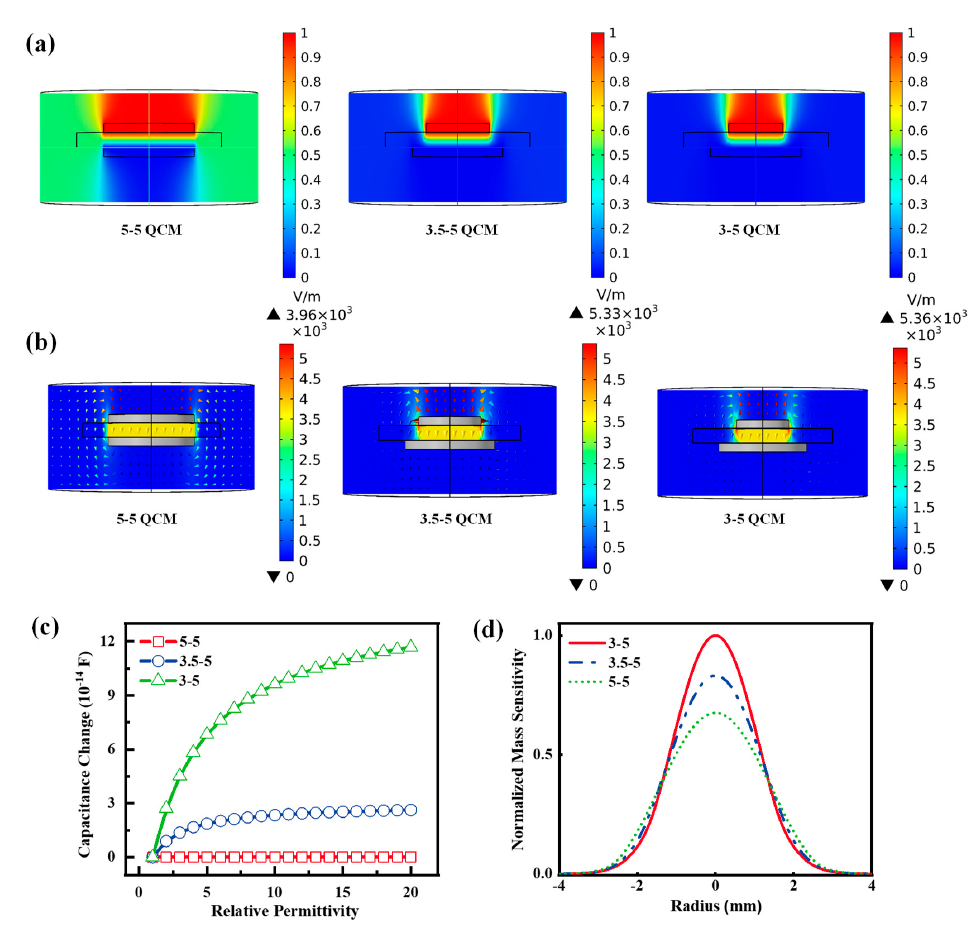
Figure 7. ( a , b ) The distribution of the potential and electric field of 5-5 QCM, 3.5-5 QCM, and 3- 5 QCM. ( c ) The normalized mass sensitivity of the QCM with symmetric and asymmetric electrodes. ( d ) Simulation results of capacitance change VS relative permittivity for the 5-5, 3.5-5, and 5-5. For simplicity, 4 mm diameter, 500 nm-thick cylinders were placed in the center of QCMs to simulate the moisture-sensitive layer. Figure 7c shows the change capacitance to 5-5 QCM, 3.5-5 QCM, and 3-5 QCM as the relative permittivity of the moisture-sensing